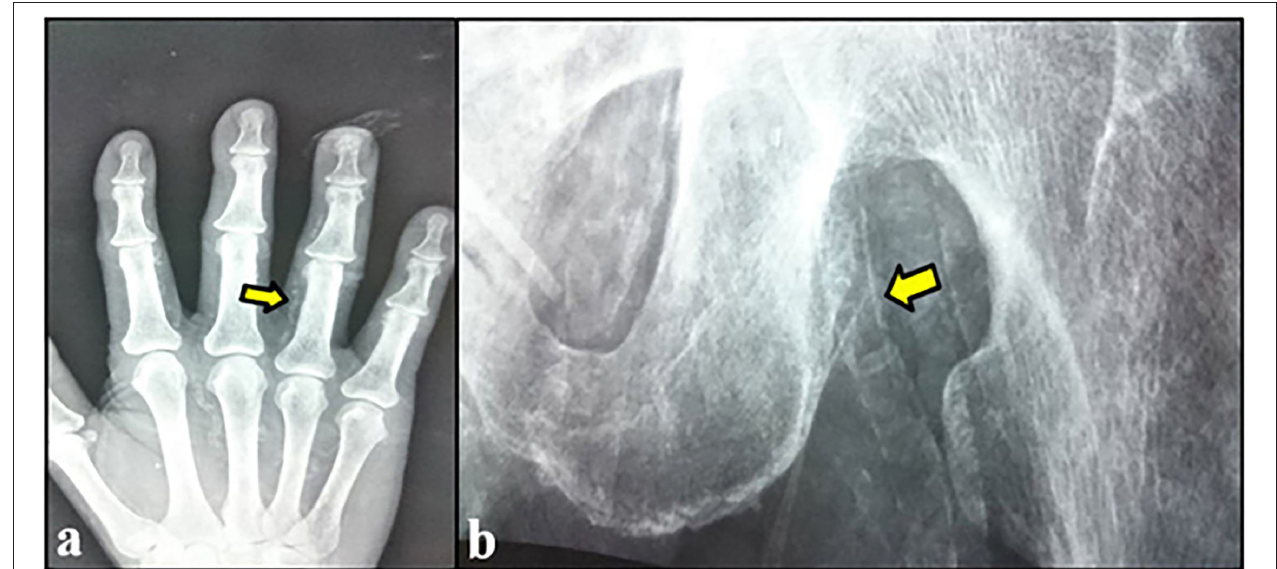
FIGURE 3 | Aortic and Mitral valves calcification. MVC, Mitral valve calcification; AVC, Aortic valve calcification.